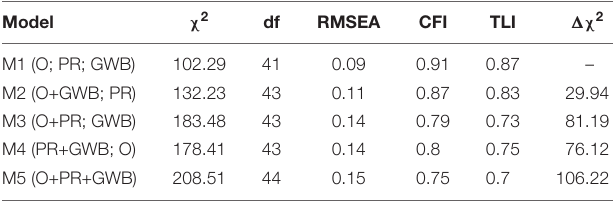
TABLE 3 | Model fit results for confirmatory factor analyses ( n = 161).